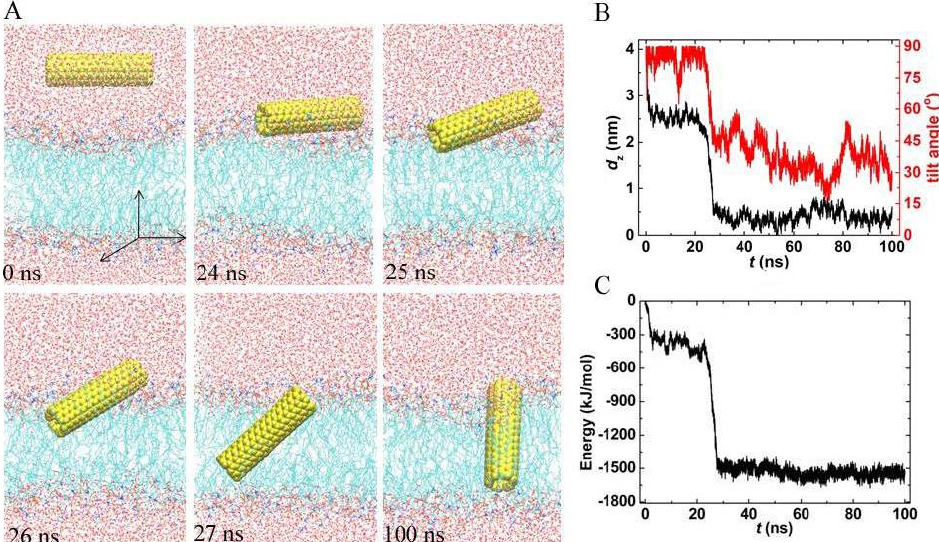
Figure 1. A typical trajectory of pristine carbon nanotubes (PCNT) entering the membrane. ( A ) Snapshots at critical times. ( B , C ) Time evolutions of the center of mass (COM) distance in the z -direction, the tilt angle, and the interaction energy between PCNT and membrane.